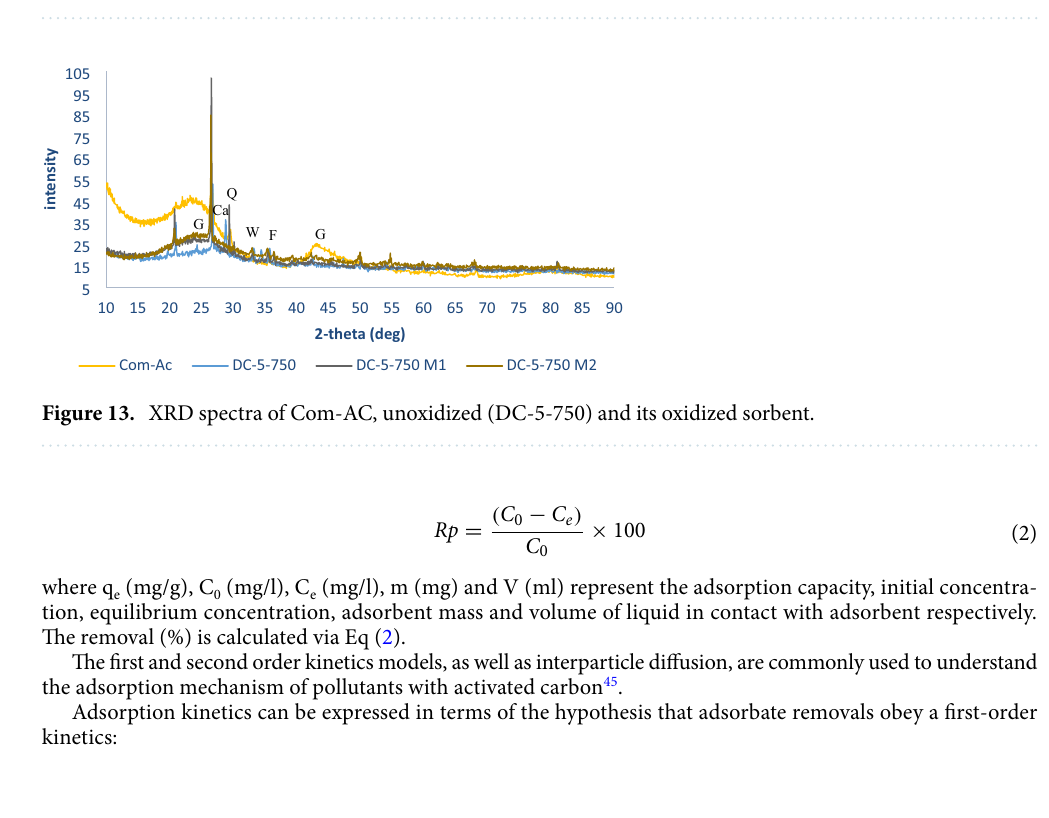
Figure 12. morphology of ( a ) DC-5-750, ( b ) DC-5-750 M1 and ( c ) Com-AC.